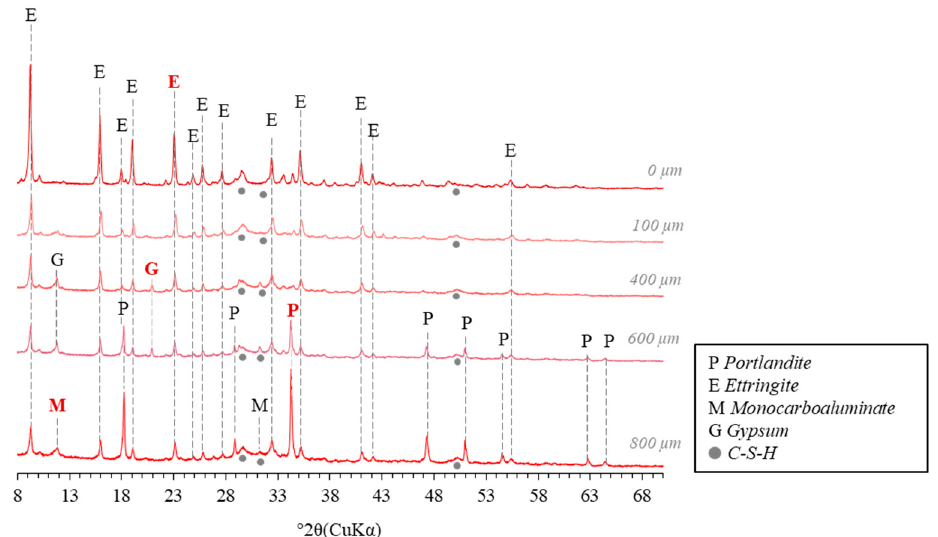
Figure A1. XRD diagrams of the 60-day degraded cement paste at critical sample depths. The heights of peaks marked in red were plotted as a function of depth (Figure 2).